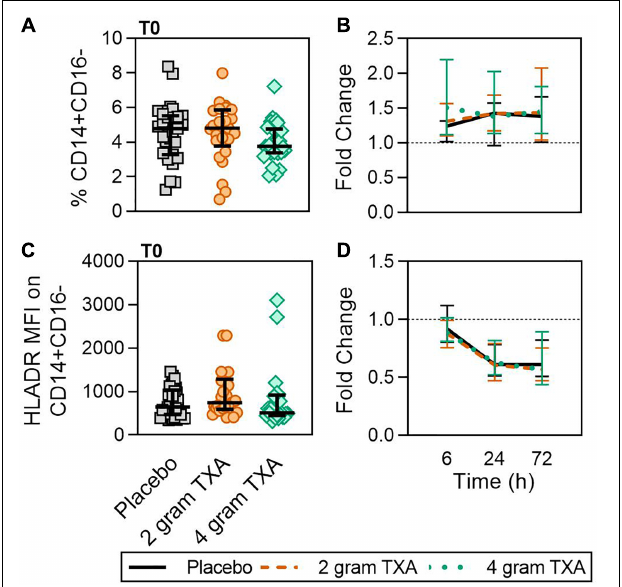
FIGURE 2 | TXA administration does not alter monocyte expression of HLA-DR. For all kinetic data, fold change was calculated as [(frequency/MFI/concentration of a given population/analyte at the given time | | T6,T24,T72| |) ÷ (frequency/MFI/concentration of the same population/analyte at T0)]. Data are displayed as line graphs (fold change, median + IQR). The dashed line placed at y = 1 represents T0, or baseline. Placebo, n = 29; 2 g TXA, n = 24; 4 g TXA, n = 25. Statistical differences between the 4 g TXA and placebo groups at each given time point, as calculated via Kruskal-Wallis, are noted as follows: p > 0.05, not significant and not denoted on the graphical representation. (A) The frequency of CD14 + CD16 - monocytes found in total peripheral blood leukocytes at T0 in all three treatment groups; data are represented as individual points with median + IQR for error bars. (B) Fold change in frequency of CD14 + CD16 - monocytes found in total peripheral blood leukocytes over the study period of